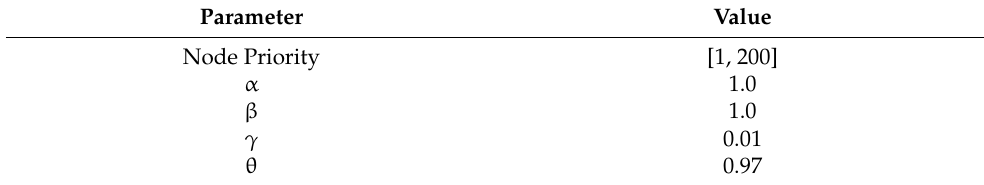
Table 9. Parameters used in Firefly-based data reporting